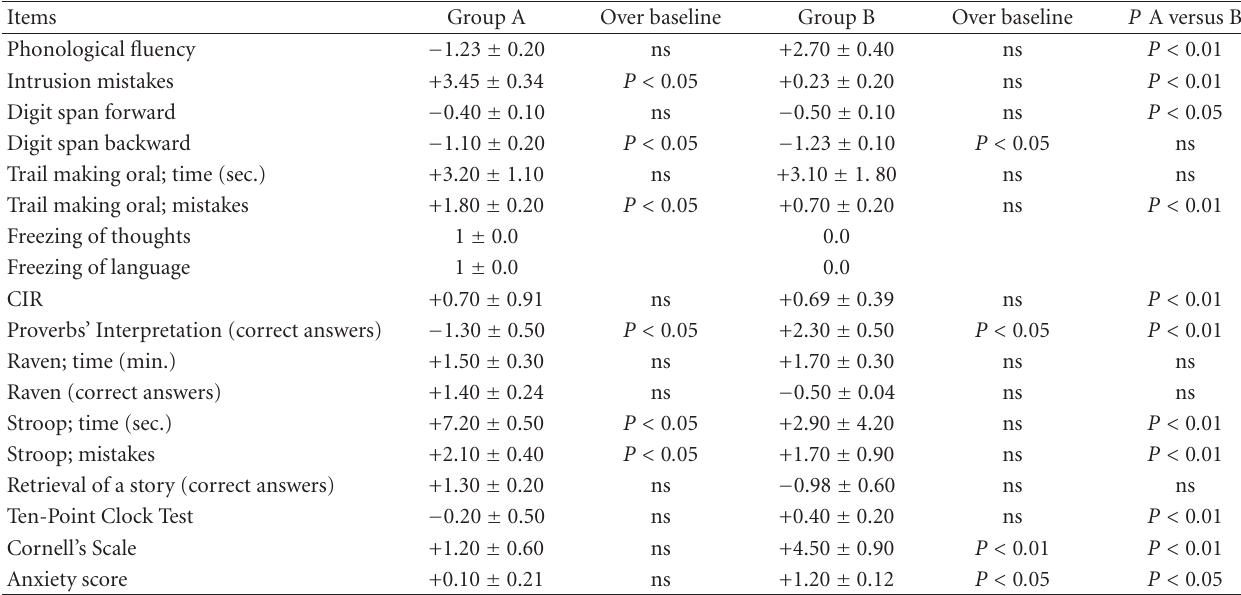
Table 4: A comparison between the two groups, at 12